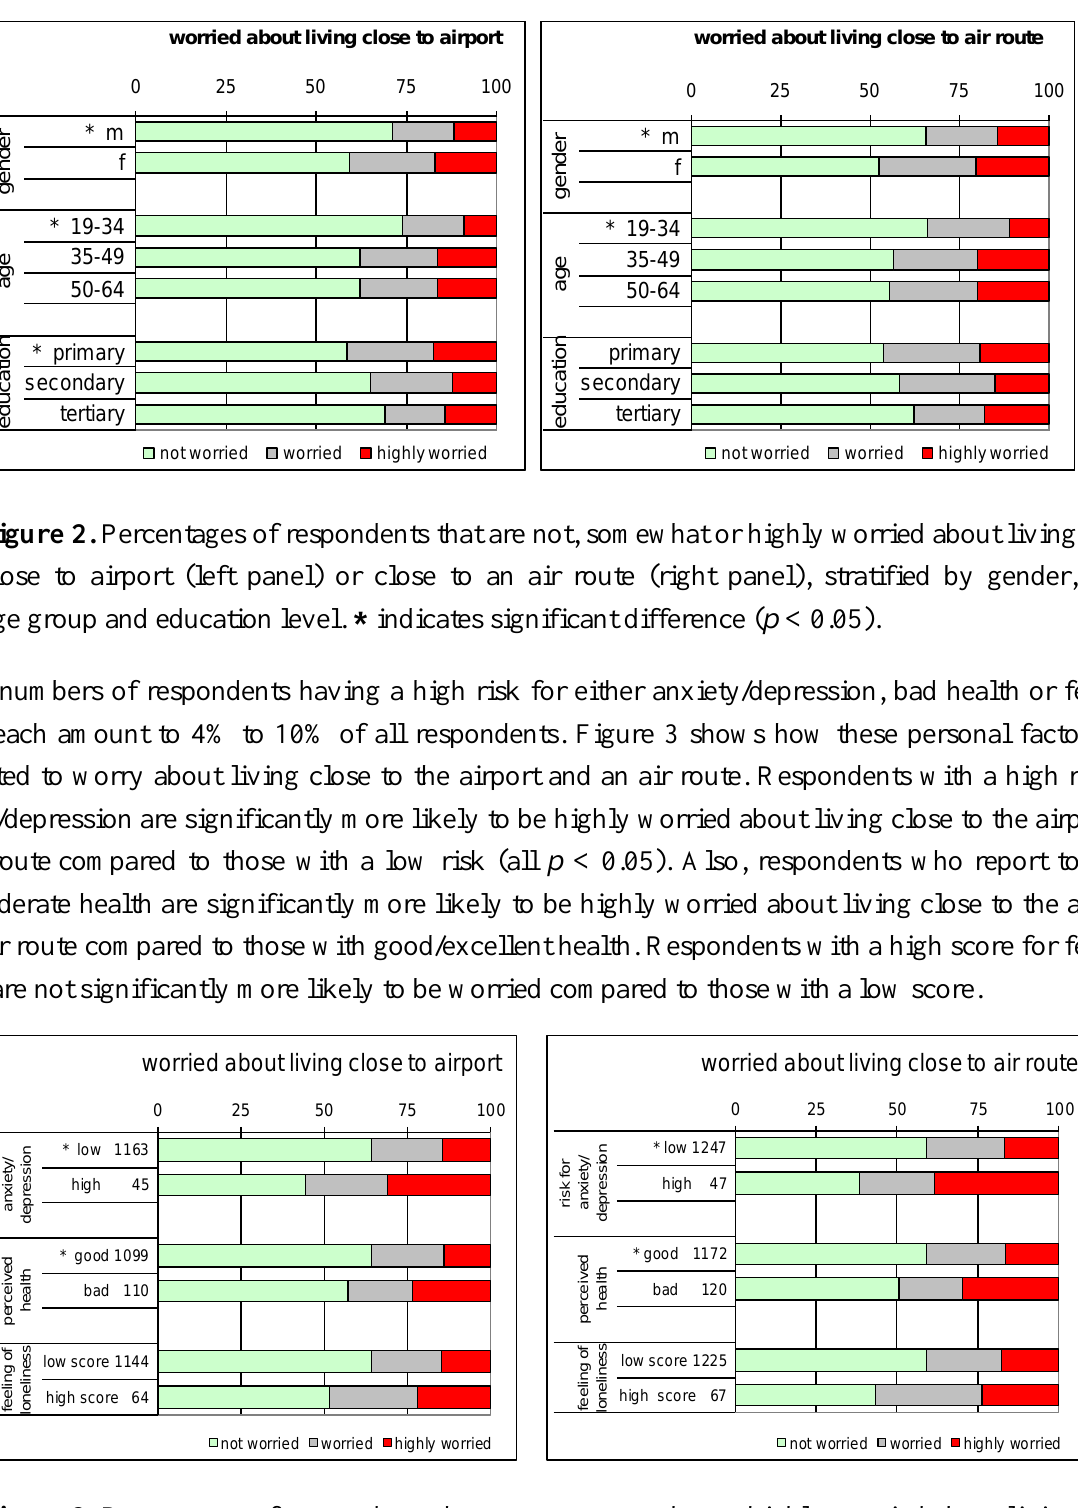
Figure 3. Percentages of respondents that are not, somewhat or highly worried about living close to airport (left panel) or close to air route (right panel), depending on risk for anxiety/depression, perceived health and feelings of loneliness. Numbers are number of respondents. * indicates significant difference ( p <